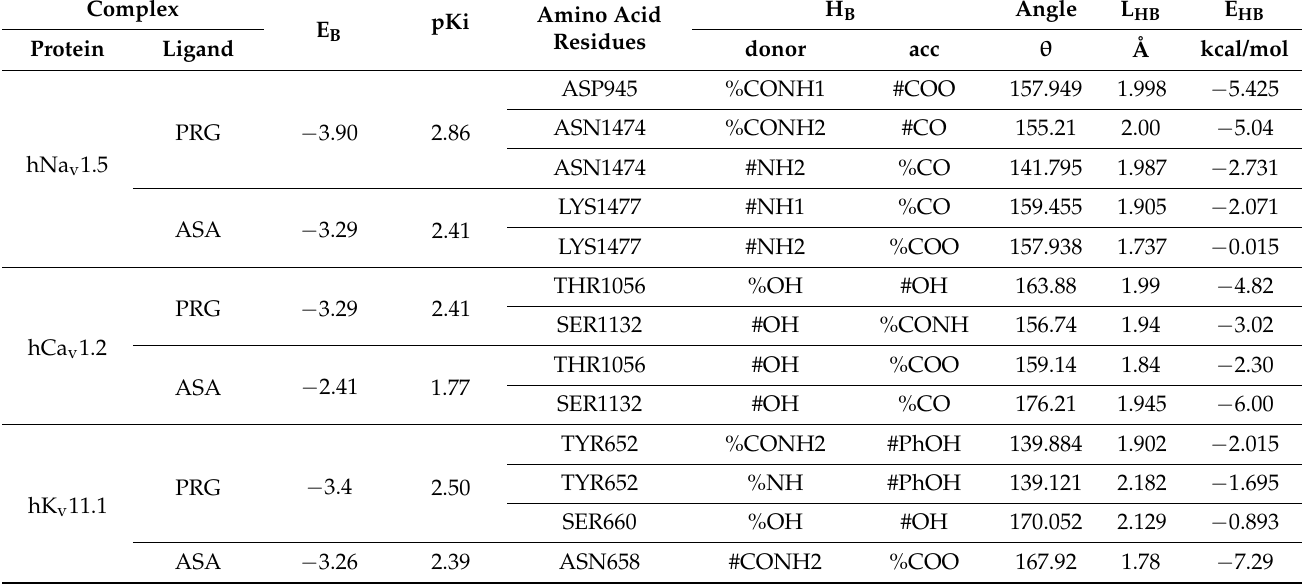
Table 3. The summary of validation experiment